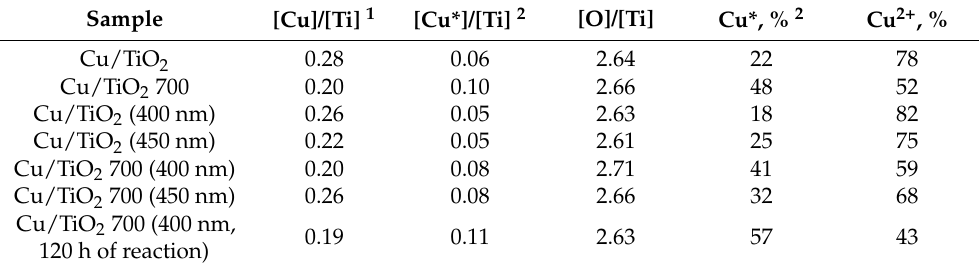
Figure 6. HAADF STEM micrographs of ( a ) fresh Cu/TiO 2 and ( b ) Cu/TiO 2 700 photocatalysts. The arrows indicate the copper nanoparticles. The bright area corresponds to copper atoms. Table 2. Atomic ratios of elements in the surface layer of samples Cu/TiO 2 and Cu/TiO 2 700 before and after photocatalytic reaction. In parentheses is the diode that was used to carry out the reaction in the case of samples